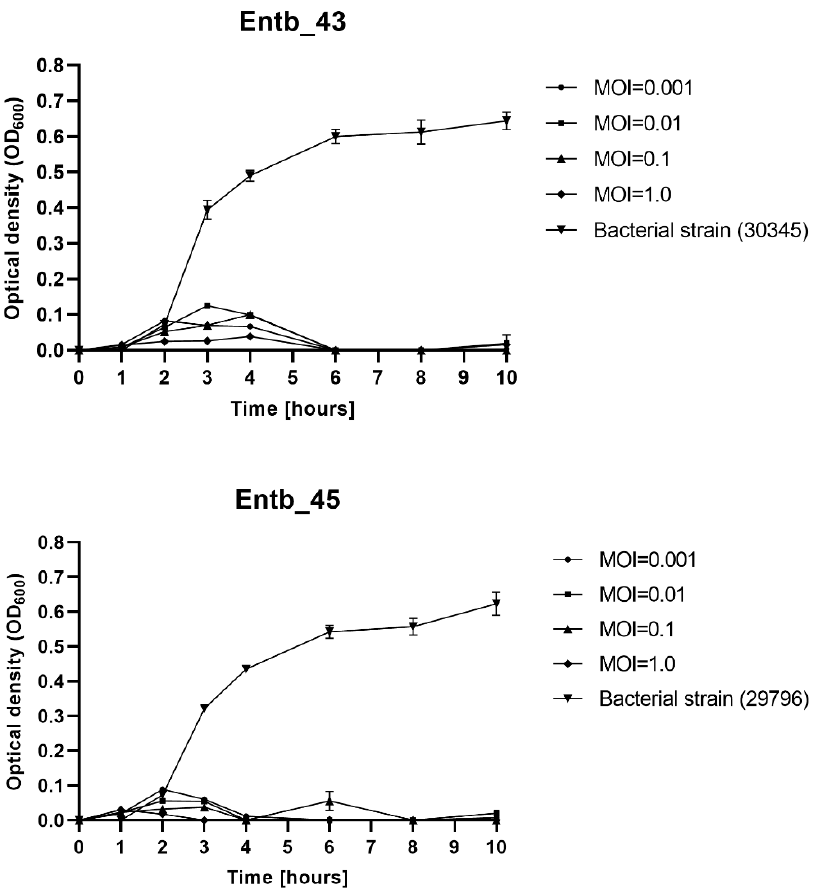
Figure 2. Planktonic cell lysis assay for phage Entb_43 and phage Entb_45. Sample measurements were performed in triplicate in two independent experiments. Error bars represent the standard deviation (±SD) of the mean phage titers.